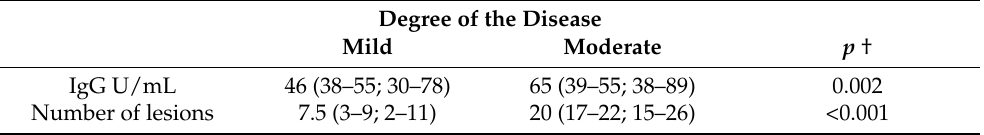
Table 6. Median (IQR, min–max) IgG and number of lesions in relation to disease severity.